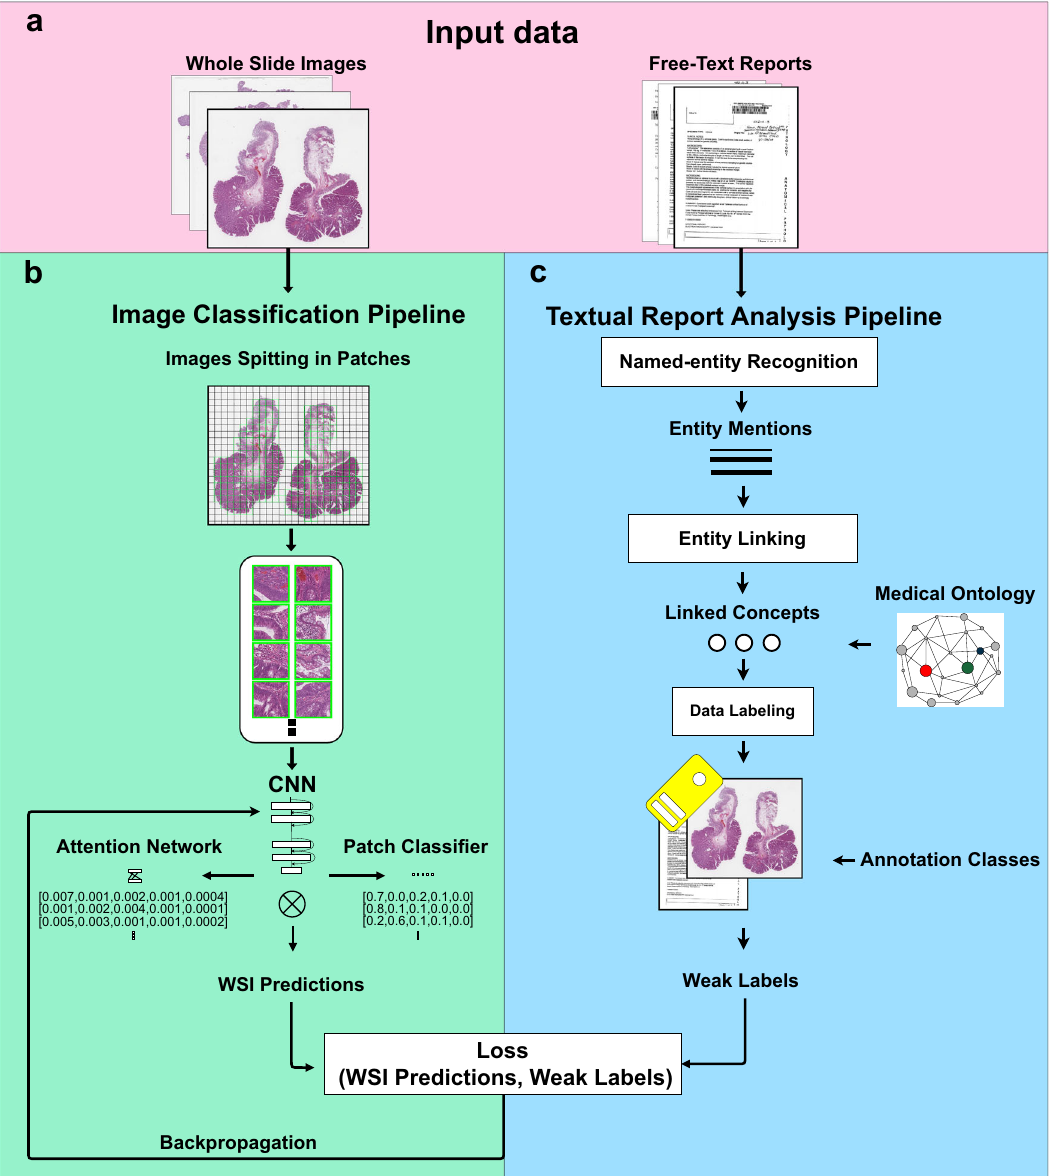
Fig. 1 Overview of the analysis pipeline. a Input data from the clinical work fl ow (pink background) including WSIs (left) and the corresponding free-text pathology reports (right). b Image Classi fi cation pipeline (green background) includes WSI pre-processing and image classi fi cation. The WSI pre-processing involves the image splitting into patches from magni fi cation x10, with a size of 224×224 pixels to fi t the pre-trained ResNet34 architecture. The image classi fi cation involves a CNN, trained using a Multiple Instance Learning algorithm. The CNN includes a frozen ResNet34 backbone (convolutional layers with ImageNet weights) that produces feature vectors with 512 elements per patch; an embedding layer to reduce the feature vector to 128 elements; a classi fi er that produces predictions at patch-level; an attention network, that learns to identify relevant patches and aggregates the patch-level predictions to have a global WSI-prediction. c The textual report pipeline automatically analyzes pathologist reports, to identify meaningful concepts to be used as weak labels for the